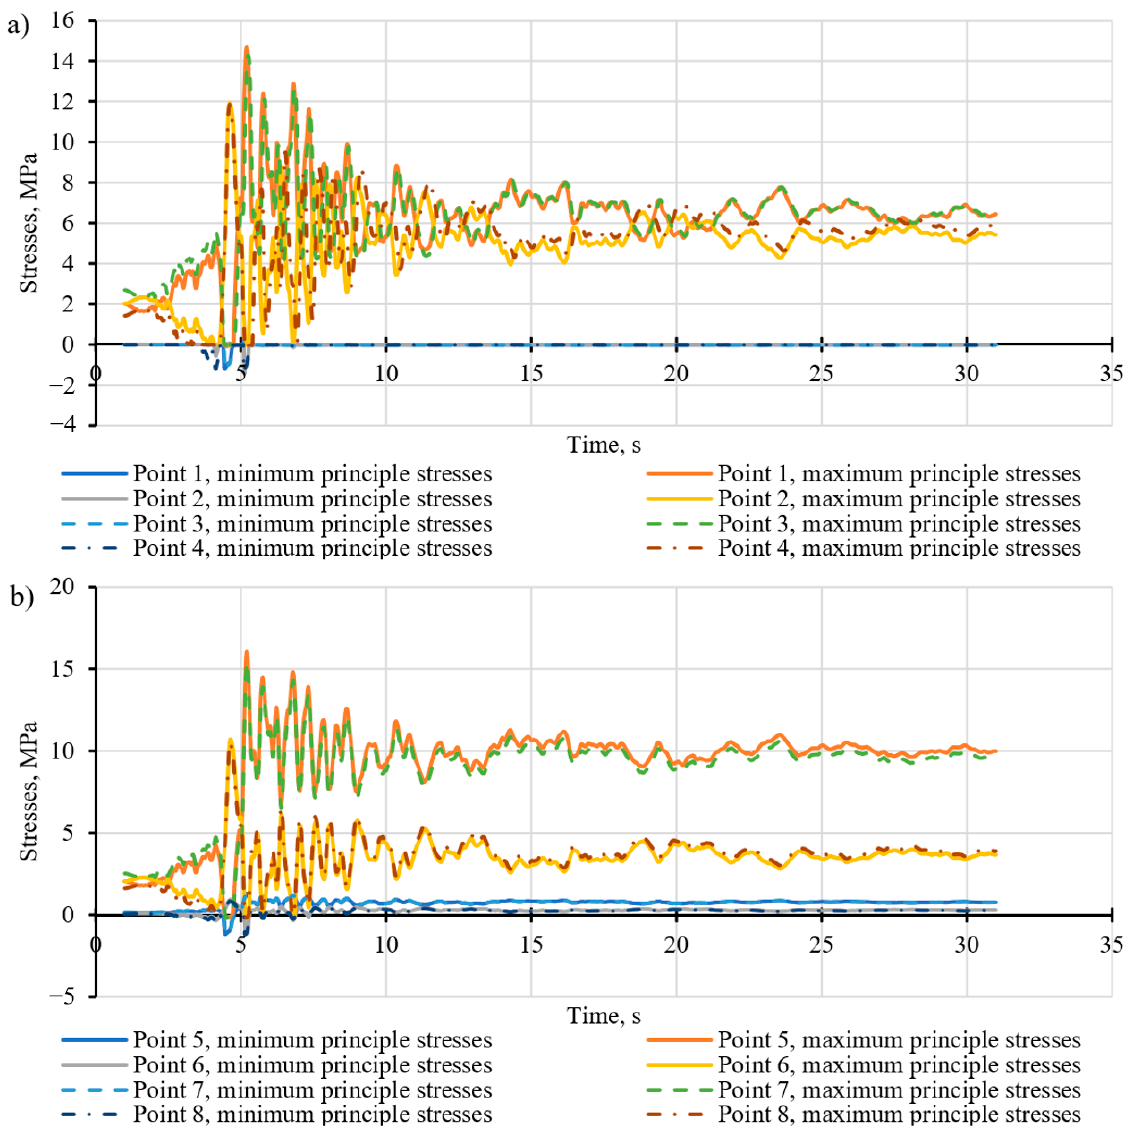
Figure 14. Curves of the maximum and minimum principal stresses in the tunnel lining made of non-reinforced concrete under seismic load for the points of the inner contour ( a ) and the outer contour ( b ).